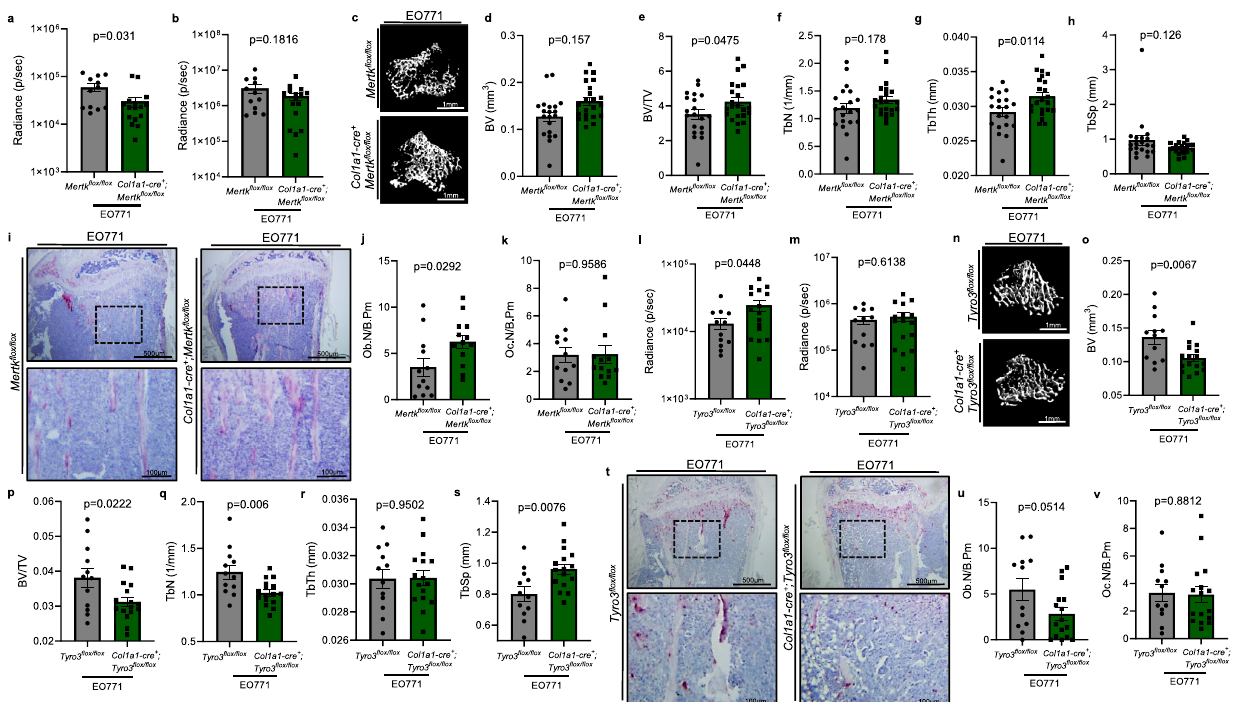
Fig. 7 | Mertk de fi cient mice display reduced bone loss in a syngeneic breast cancer bone metastasis mouse model. a – k Luciferase + EO771 breast cancer cells were injected intracardially in Mertk fl ox/ fl ox and Col1a1-cre + ; Mertk fl ox/ fl ox mice. a , b Analysis of tumor load in the tibia by Bioluminescence Imaging after 3 ( n =12/ 16)( a ) and 7 ( b )( n =12/16)days. c – h μ CT3Dreconstructions ( c )and analysis of BV ( n =20/22)( d ),BV/TV( n =20/22)( e ),Tb.N( n =20/22)( f ),Tb.Th( n =20/22)( g ),and Tb.Sp ( n =20/22) ( h ) of trabecular bone of metaphyseal proximal region of the tibia. i RepresentativepicturesofTRAP/Hematoxylinstainingofbonemetastasisof EO771 injectedmice. j , k Histomorphometric analysisof osteoblast number (Ob.N/ B.Pm) ( n =12/13) ( j ) and osteoclast number (Oc.N/B.Pm) ( n =12/13) ( k